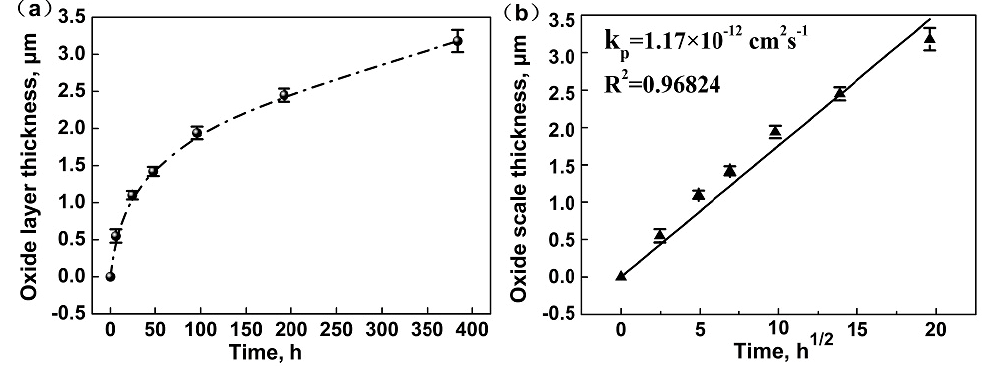
Figure 4. Oxides scale thickness as a function of ( a ) annealing time and ( b ) square root of annealing time.